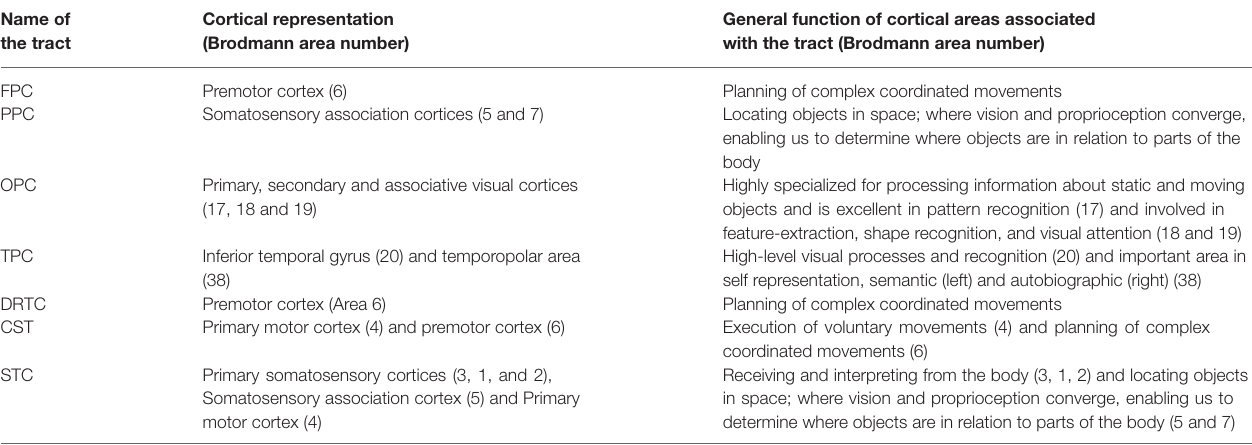
TABLE 1 | The cortical origin and termination of the fronto-ponto-cerebellar (FPC), parieto-ponto-cerebellar (PPC), occipito-ponto-cerebellar (OPC), temporo-ponto-cerebellar (TPC), dentate-rubro-thalamo-cortical (DRTC), corticospinal (CST) and spinothalamocortical (STC) tracts are summarized . Name of